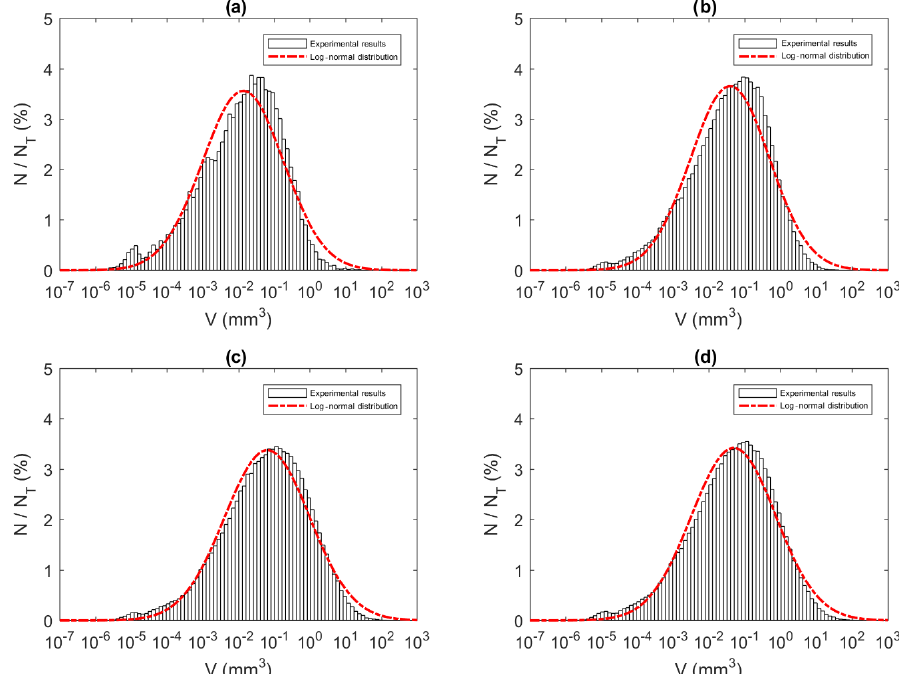
Figure 15. Size distributions of floc volume at a salinity of 35‰ during (a) Phase 1, (b) Phase 2, (c) Phase 3 and (d) the entire time interval (i.e. average over all three phases). N is the number of flocs in each bin, N T is the total number of flocs ( N T ≈ 23880, 136950, 270790 and 431620 in a , b , c and d , respectively) and V is the estimated floc volume (mm 3 ). Note that the arithmetic mean of flocs volumes were 0.16, 0.31, 0.78 and 0.60mm 3 for (a) , (b) , (c) and (d) ,